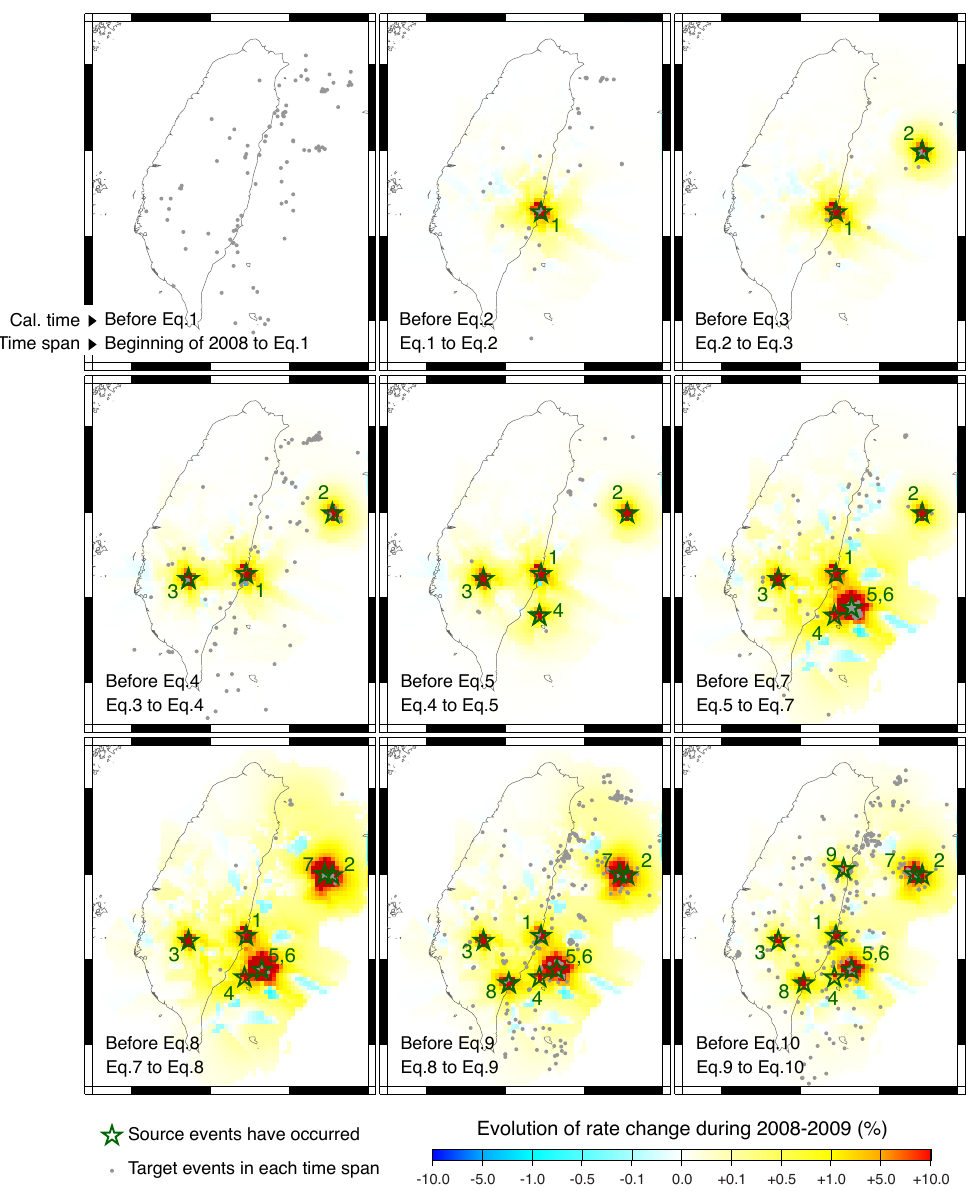
Fig. 3. The short-term seismicity rate change acquired using the rate-and-state friction model for various periods. Source events during 2008–2009 are shown as open green stars. Target earthquakes during each time span are shown as gray dots. Source parameters of the source events necessary for calculating the seismicity rate change are shown in Table